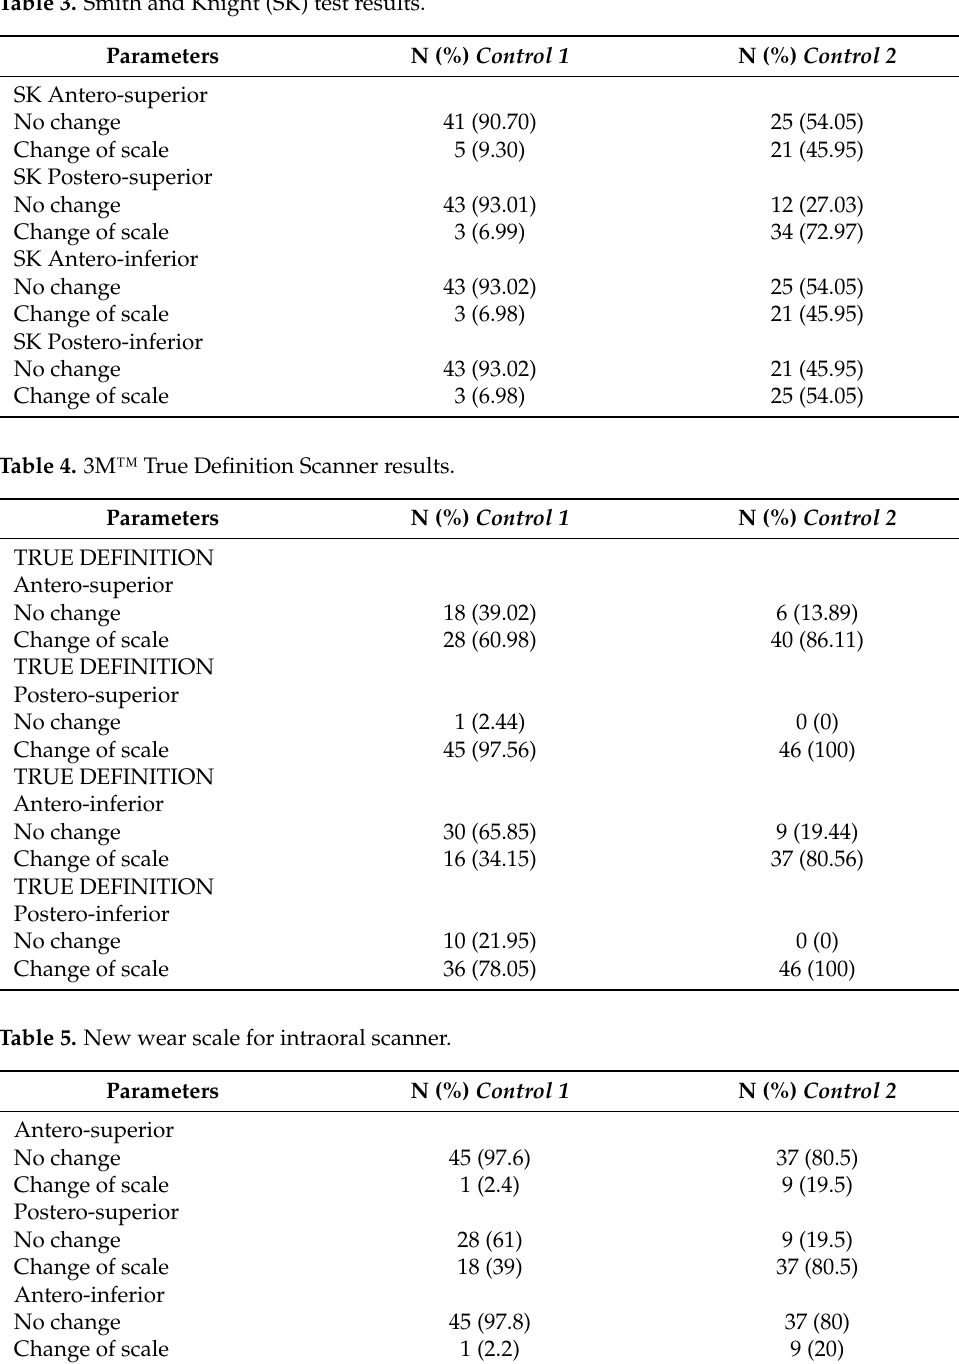
Table 3. Smith and Knight (SK) test results.